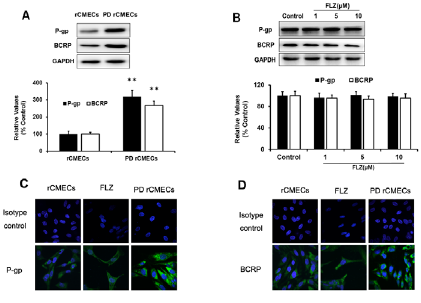
Figure 4. Western blot and confocal microscopy analysis of the expression of P-gp and BCRP in rCMECs. The relative level of the proteins was determined by densitometry. PD rCMECs showed a significant increase of P-gp and BCRP level relative to normal rCMECs detected by Western blot (A). Results are expressed as mean 6 SD (n=3). ** P , 0.01 , significantly different from normal rCMECs group. No difference in P-gp and BCRP levels of rCMECs treated with 10 m M FLZ for 24 h (B). A Similar tendency could be observed by immunofluores- cence of P-gp (C) and BCRP (D) staining. Bar =20 m m.